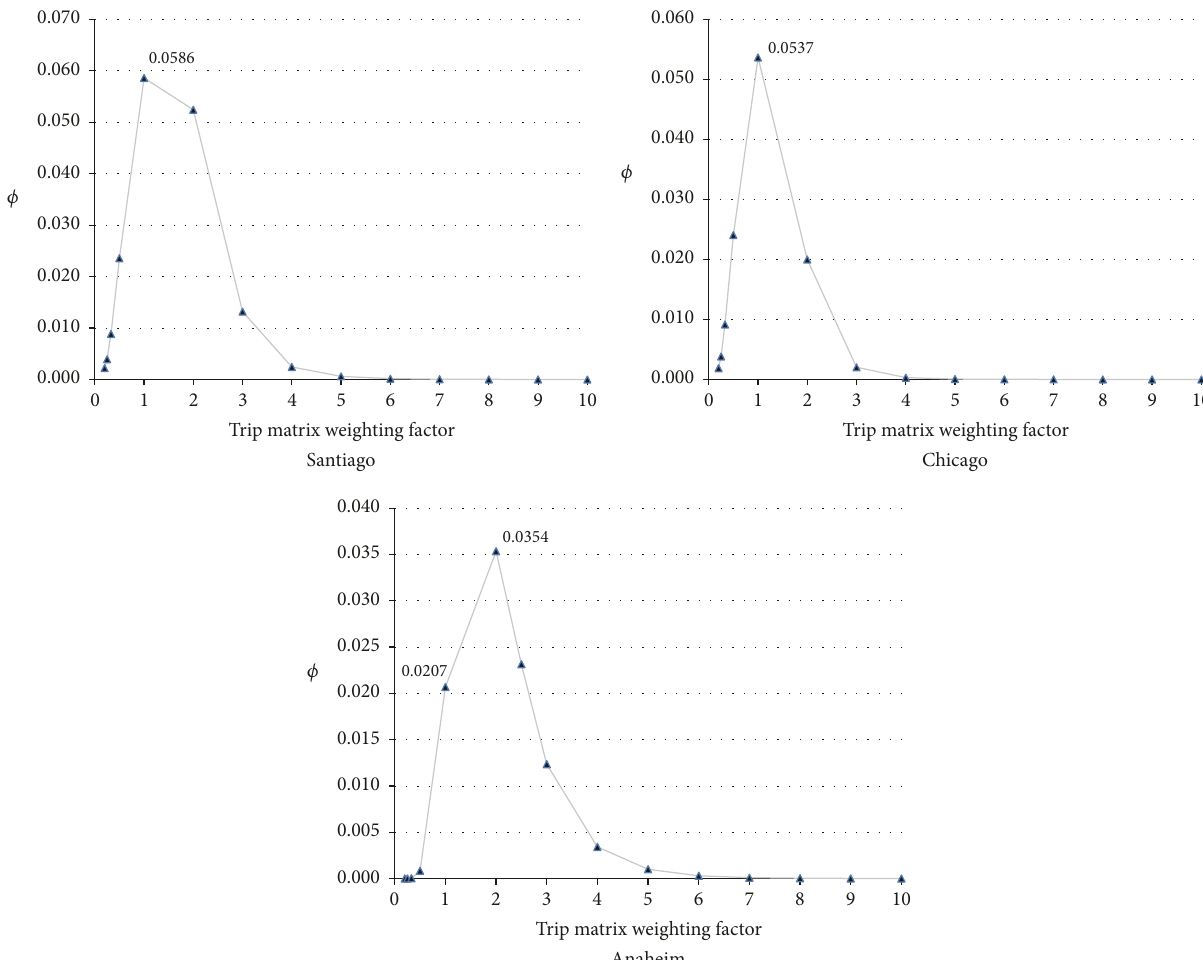
Figure 3: Relationship between 𝜙 and the demand level for each network (each curve specifies the price of anarchy using the trip matrix for the rush hour period estimated for each case. The price of anarchy for each of the Santiago and Chicago networks coincides with the maximum value. The maximum price of anarchy for the Anaheim network is obtained by doubling the number of trips (i.e., the matrix is weighted by a factor of